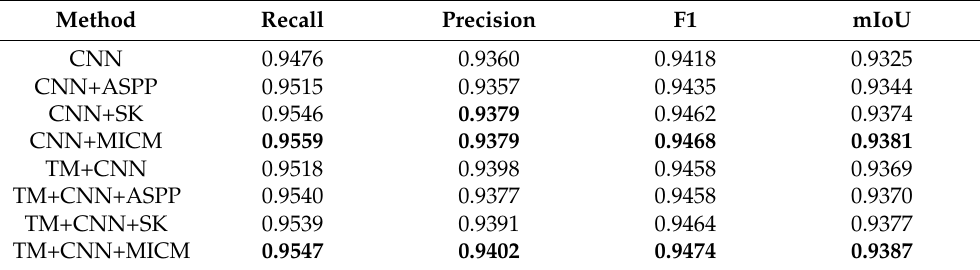
Table 7. Building extraction accuracies with different multiscale modules. The highest accuracy is displayed in bold.